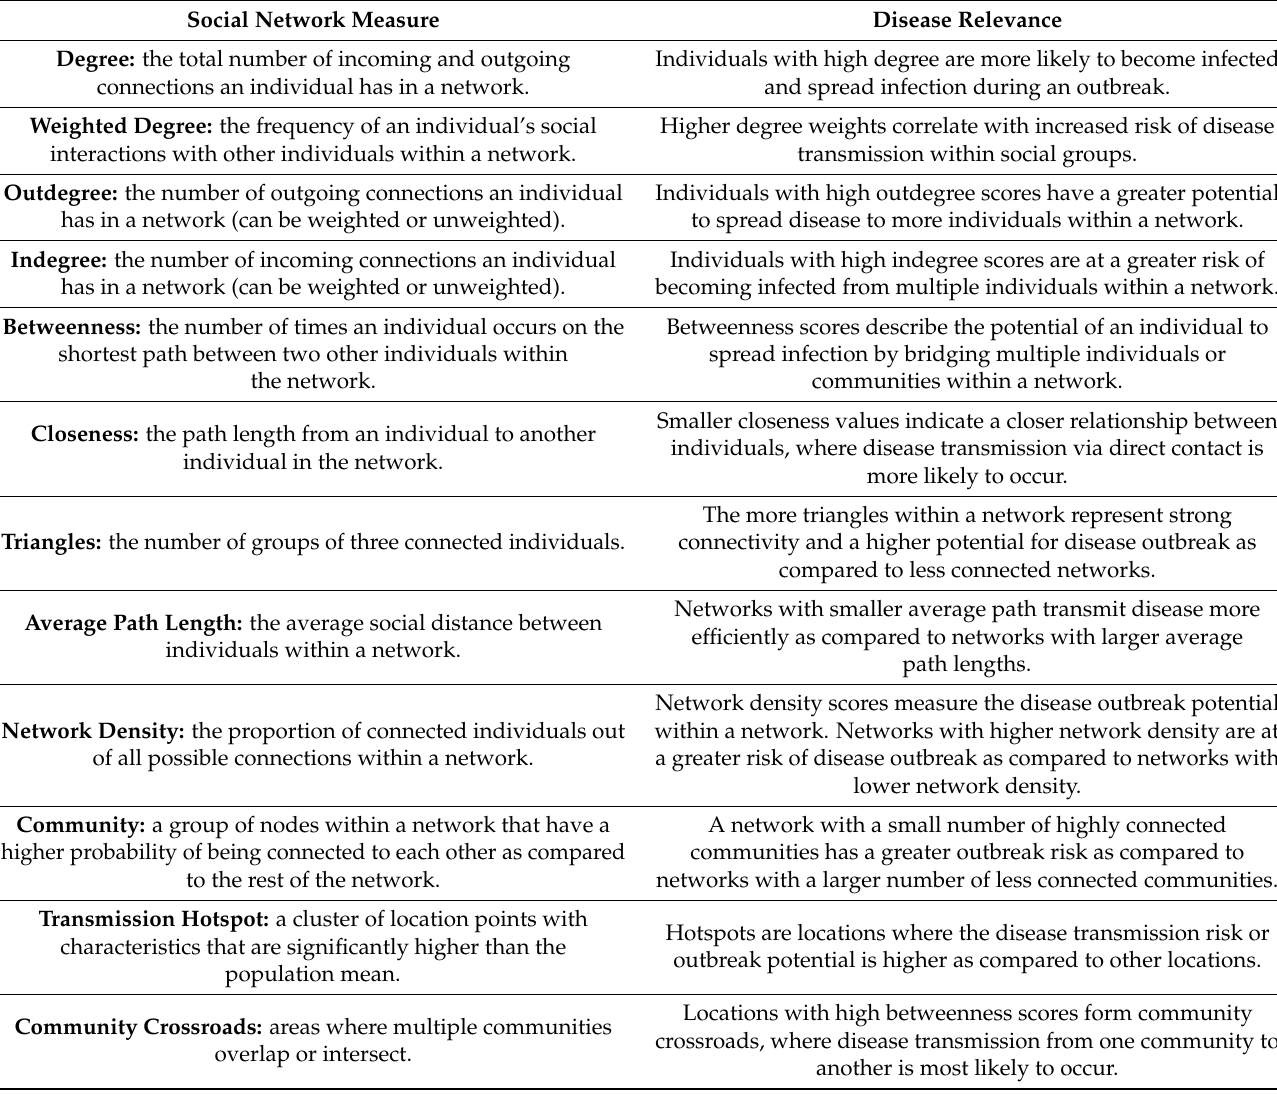
Table 1. Network Measures and Disease Relevance. The table displays the definition of each network measure and its relevance in disease